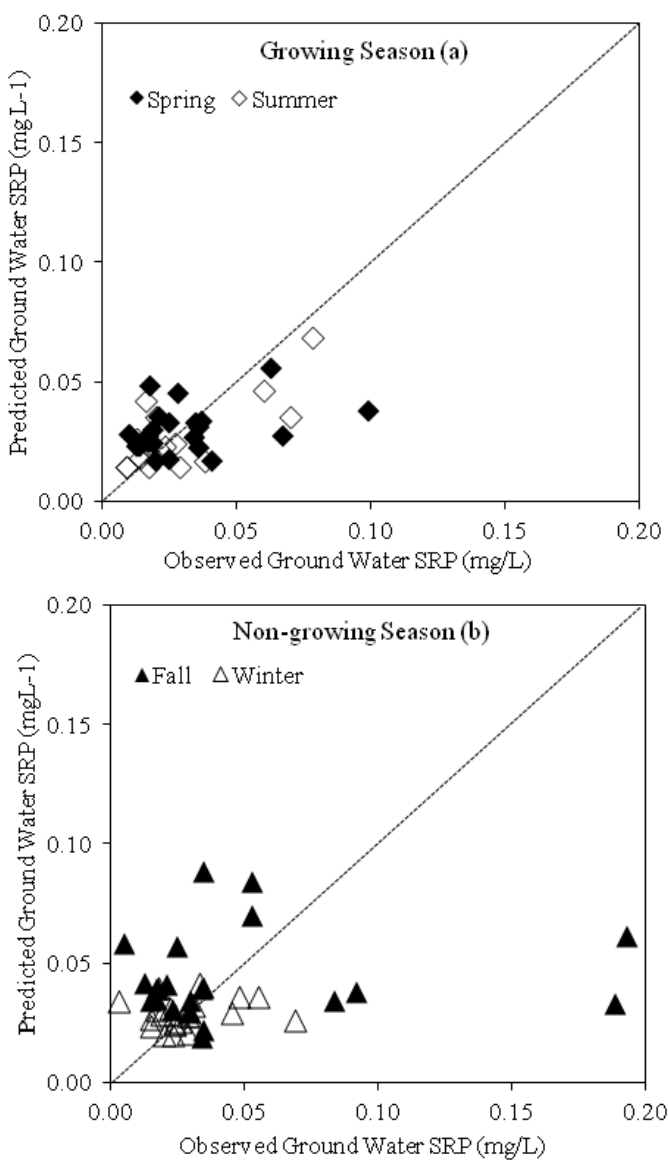
Figure 5. Observed versus predicted groundwater SRP (mg L − 1 ) for the growing ( a ); and non-growing seasons ( b ). During the fall and spring seasons, several data points were observed away from the 1:1 line, indicating an under-prediction of SRP